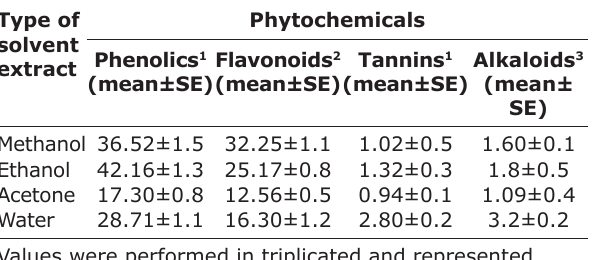
Table-2: Phytochemical presence of H. isora extract. Type of solvent extract